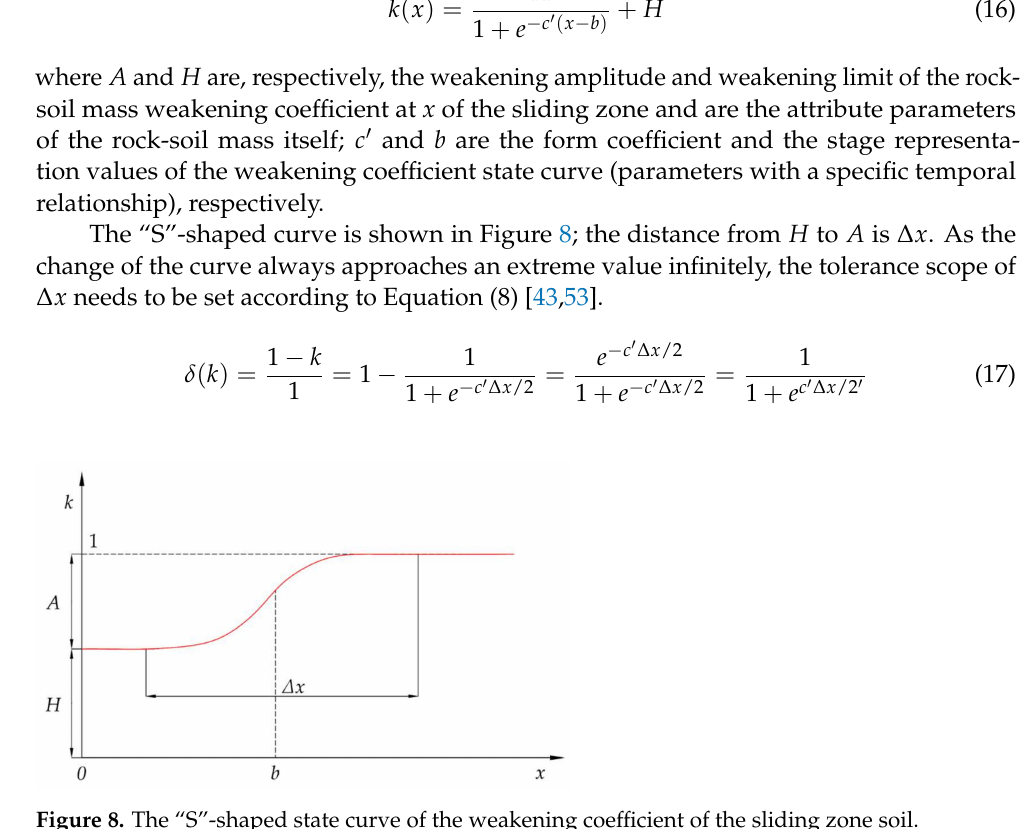
Figure 8. The “S”-shaped state curve of the weakening coefficient of the sliding zone